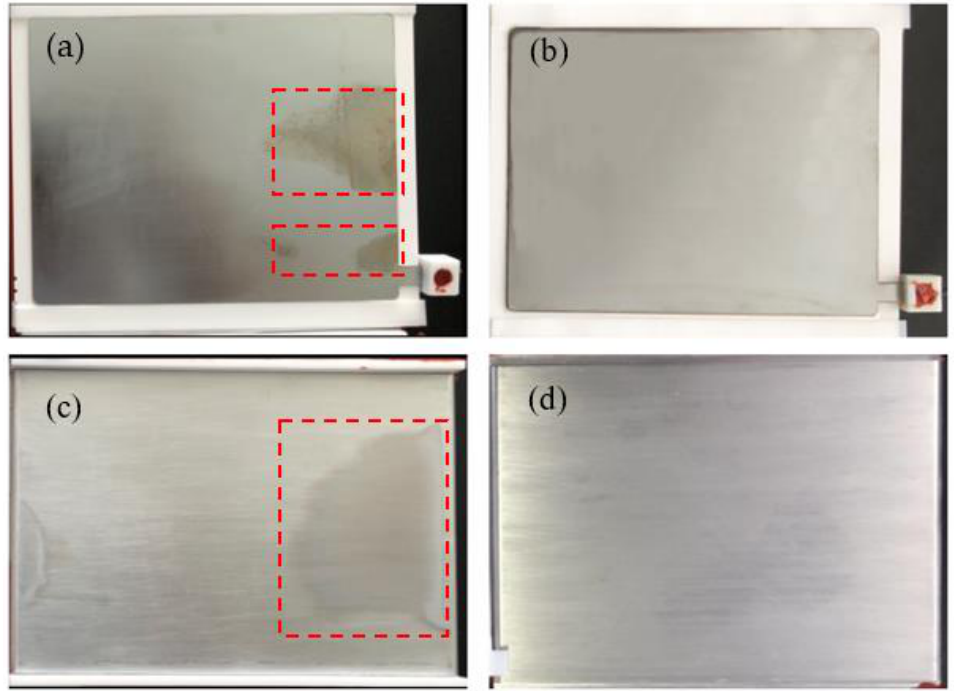
Figure 11. Morphologies of the high voltage electrode without silver layer ( a ) and with silver layer ( b ); morphologies of the ground electrode without silver layer ( c ) and with silver layer ( d ). To further examine the performance of the silver layer between the electrode and the dielectric layer, the two reactors work continuously for 8 h. The dependence of ozone concentration on the running time is shown in Figure 12. It can be seen that the C O3 varies from 149.6 g/m 3 to 151.7 g/m 3 , for the silver layer reactor at V = 2.8 kV. As regards the reactor without the silver layer, the C O3 is 137.2 g/m 3 to 141.4 g/m 3 . The C O3 of the reactor with the silver layer is stabilized at 150.6 g/m 3 within 30 min, while the C O3 of the reactor without the silver layer is about 139.4 g/m 3 . It is clear that the efficiency of the reactor with the silver layer is higher than that of the reactor without the silver layer. Furthermore, the concentration of ozone produced by the reactor covered with the silver layer is much more stable. This suggests that the reactor with the silver layer works more reliably for a long